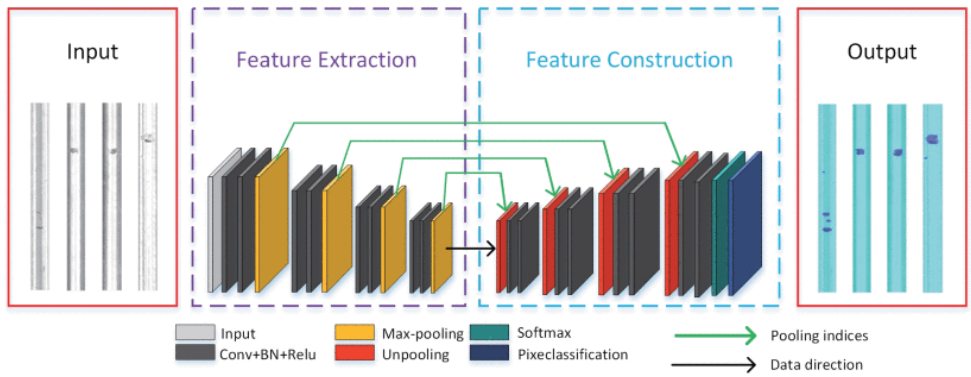
Figure 4. SegNet architecture for rail defect analysis. Reproduced with permission from IEEE